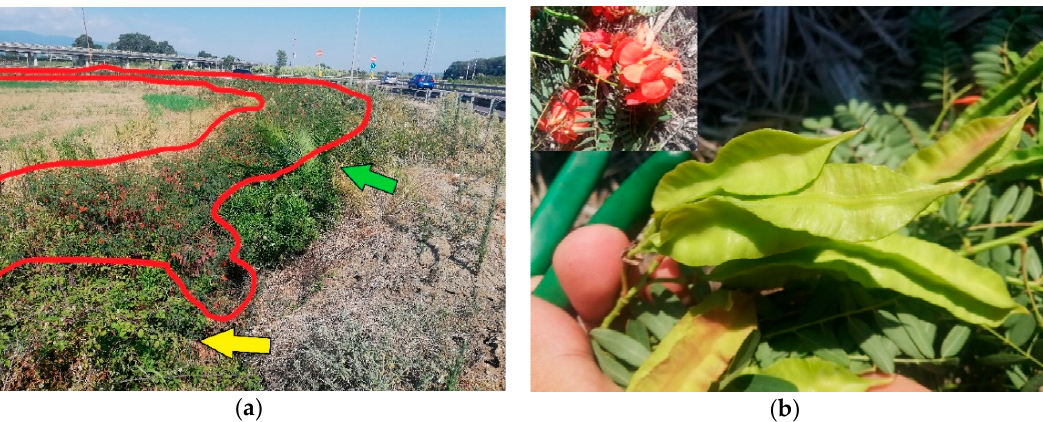
leaves, and flowers; ( b ) several plants along the riverbed of the fiumara (Photographs VLA Laface).